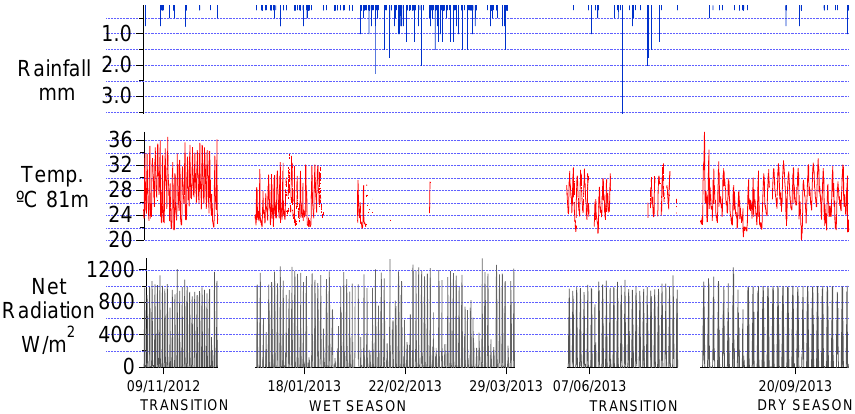
Figure 3. Meteorological data (2min averages) for the intensive measurement periods at the ATTO site for the 81m level of the tower reporting rainfall (blue), temperature (red) and net radiation (grey).